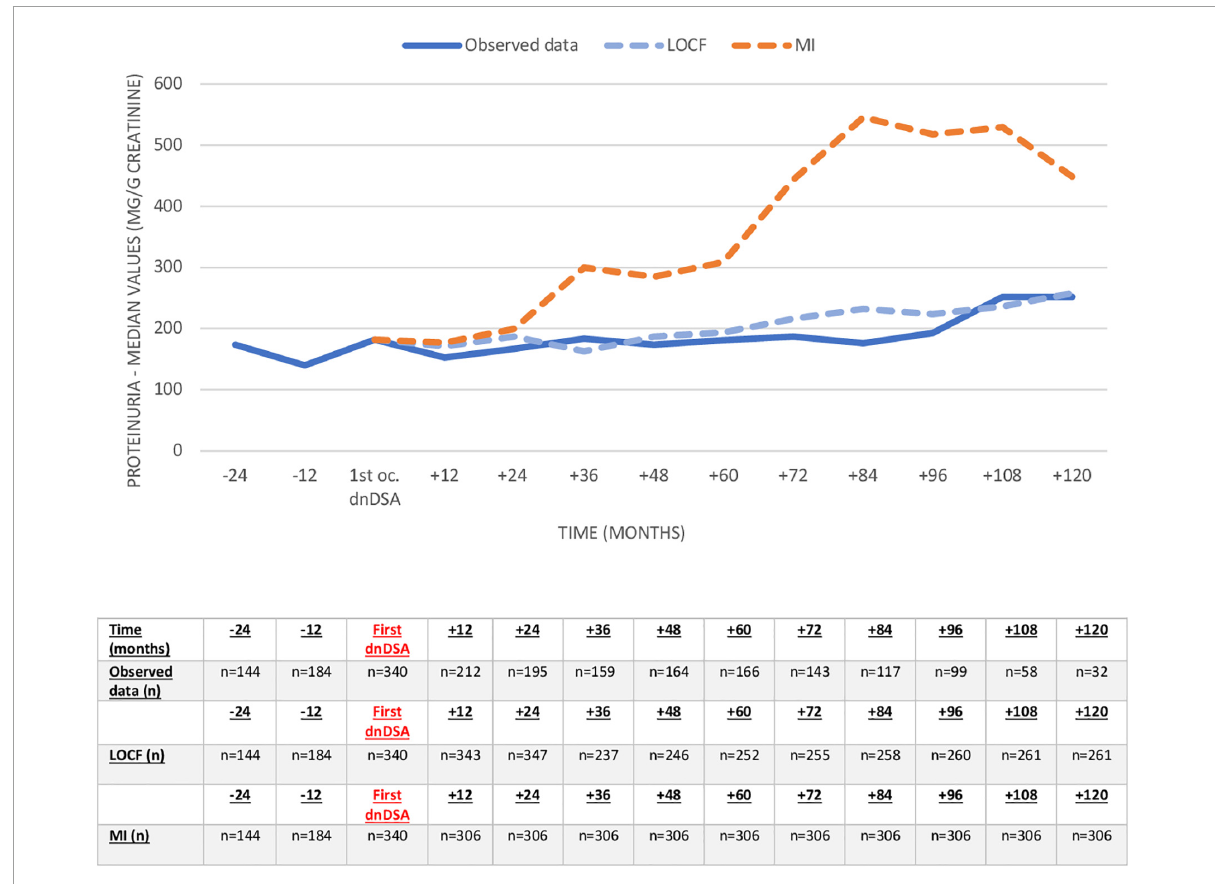
FIGURE6 Evolution of proteinuria (mg/g creatinine) before and after first occurrence of first dnDSA. Missing values after dnDSA were imputed using last observation carried forward (LOCF) analysis and multiple imputation (MI). dnDSA, de novo donor-specific antibodies.